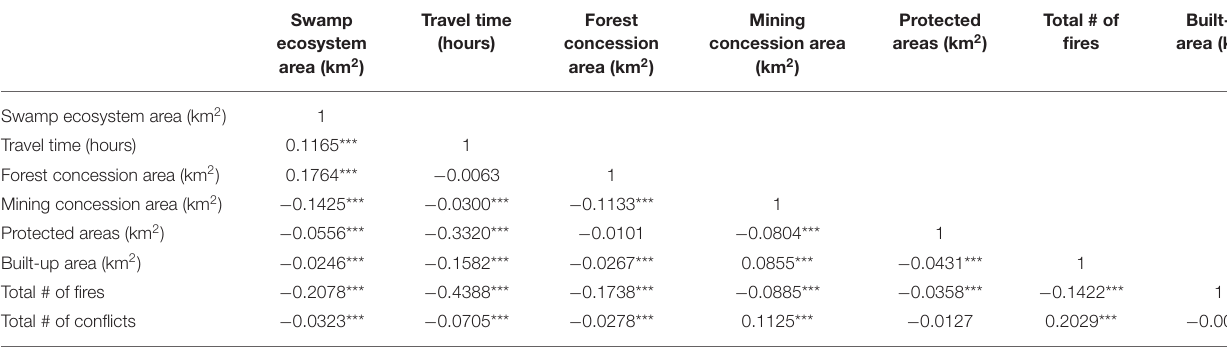
TABLE 3 | Pearson correlation matrix of independent variables.